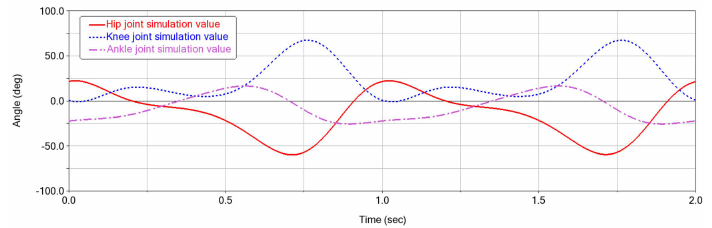
Figure 21. Joint angle changes of lower-limb exoskeleton